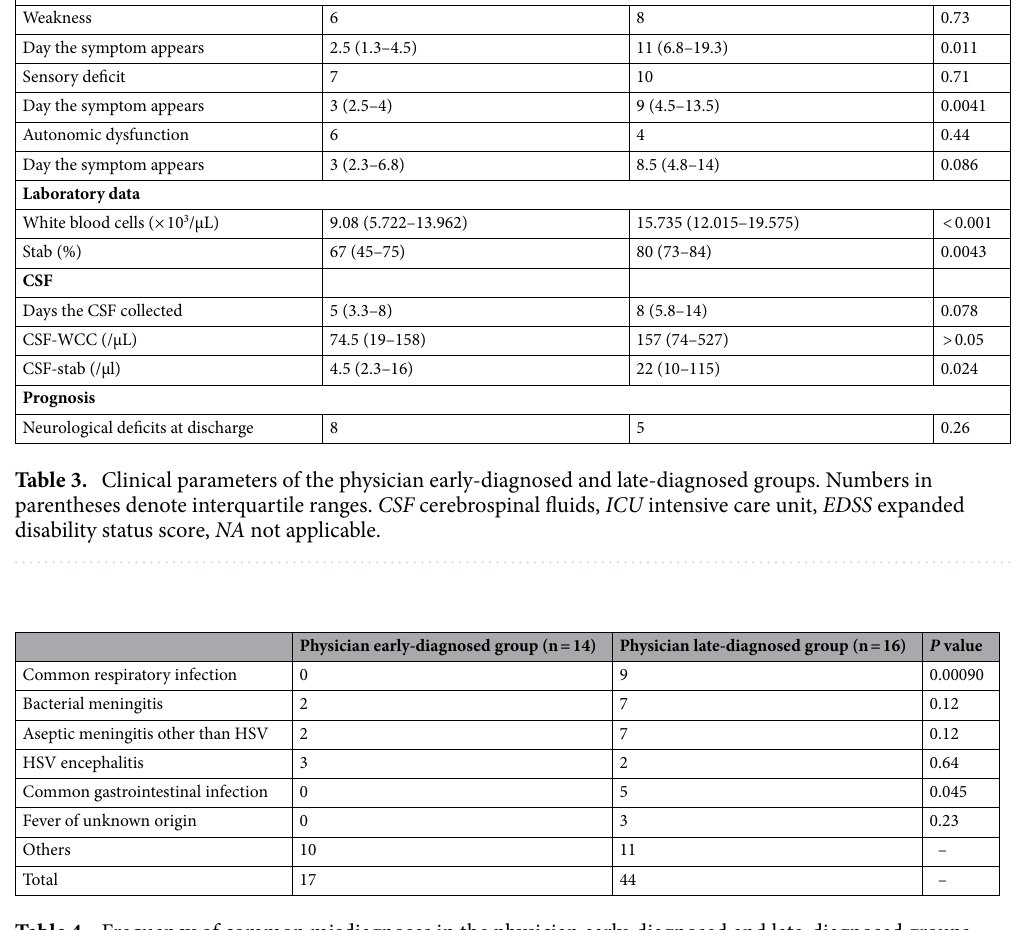
Table 4. Frequency of common misdiagnoses in the physician early-diagnosed and late-diagnosed groups. HSV herpes simplex